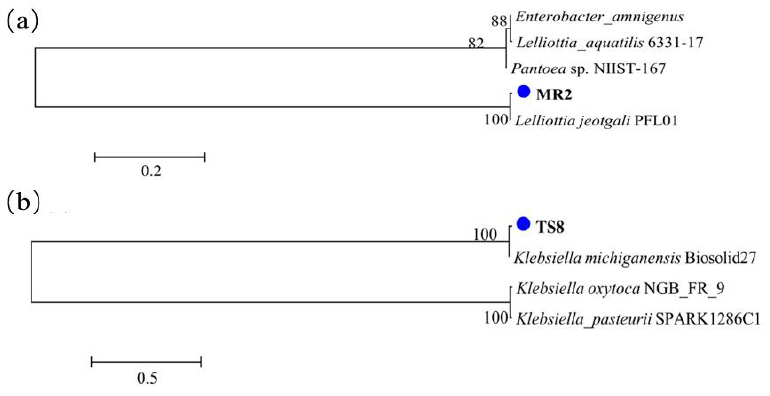
Figure 3. Neighbor-joining tree based on 16S rRNA gene sequences. ( a ) MR2 and ( b ) TS8.